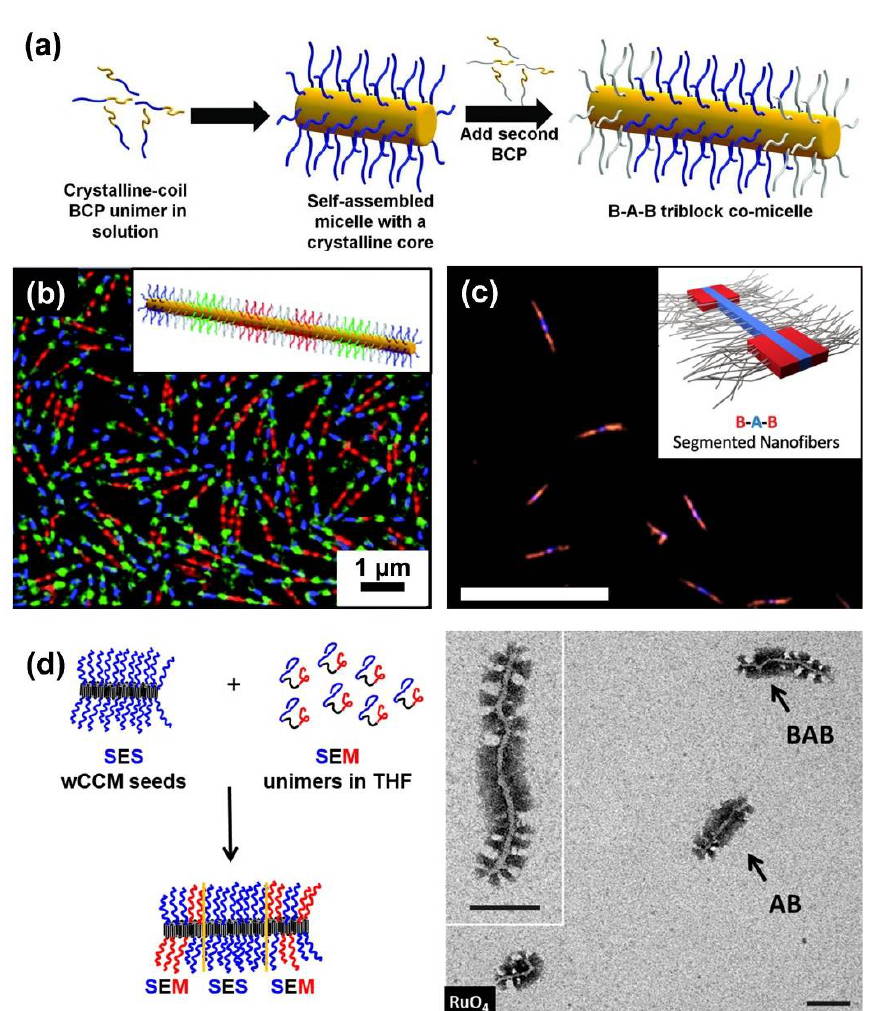
Figure 3. ( a ) Formation of B–A–B triblock co-micelles via sequential living CDSA in selective solvents for the corona blocks. ( b ) Structured illumination microscopy image of symmetrical 11-block co-micelles with red, green, and blue fluorescent corona blocks separated by non-fluorescent PDMS spacer blocks. ( c ) Laser-scanning confocal microscopy image of solid-state, donor–acceptor, coaxial heterojunction nanowires based on B–A–B segmented nanofibers with a semi-crystalline PDHF core (depicted in blue) and a semi-crystalline P3EHT shell (depicted in red) in the outer corona blocks, taken with both blue (PDHF) and red (P3EHT) channels (scale bar: 10 µm). Blue emission from the central PDHF core, as well as red/orange emission from the outer P3EHT segments, due to Förster resonance energy transfer (FRET) were observed. ( d ) Schematic depiction of the formation of B–A–B triblock co-micelles with patchy outer corona blocks, starting from SES wCCMs as seed micelles and subsequent living CDSA of SEM unimers in THF (left) and corresponding TEM image of patchy block co-micelles (scale bar: 100 nm). ( a ) Reproduced from [79] with permission of the American Association for the Advancement of Science (AAAS), ( b ) reproduced from [67] with permission of the Royal Society of Chemistry (RSC), ( c ) reproduced from [105], and ( d ) reproduced from [68] with permission of ACS.